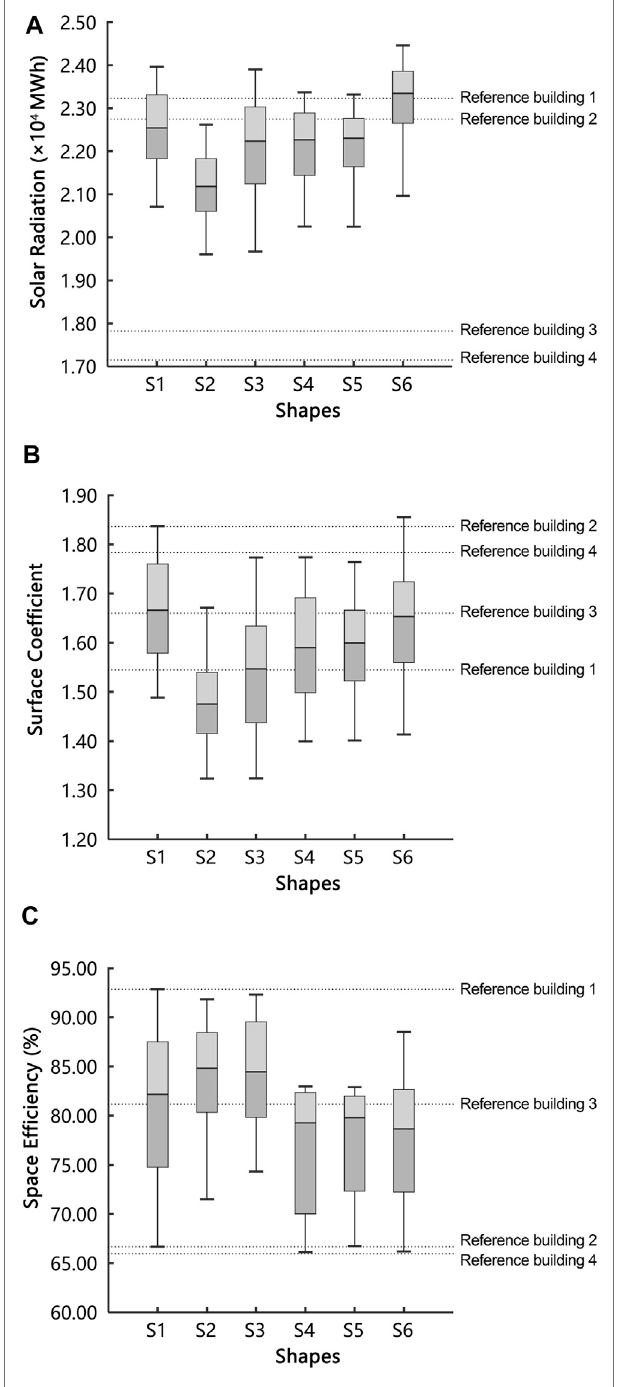
FIGURE 13 | Performance distribution of six shapes and comparison with the reference buildings: (A) solar radiation; (B) surface coef fi cient; (C) space ef fi